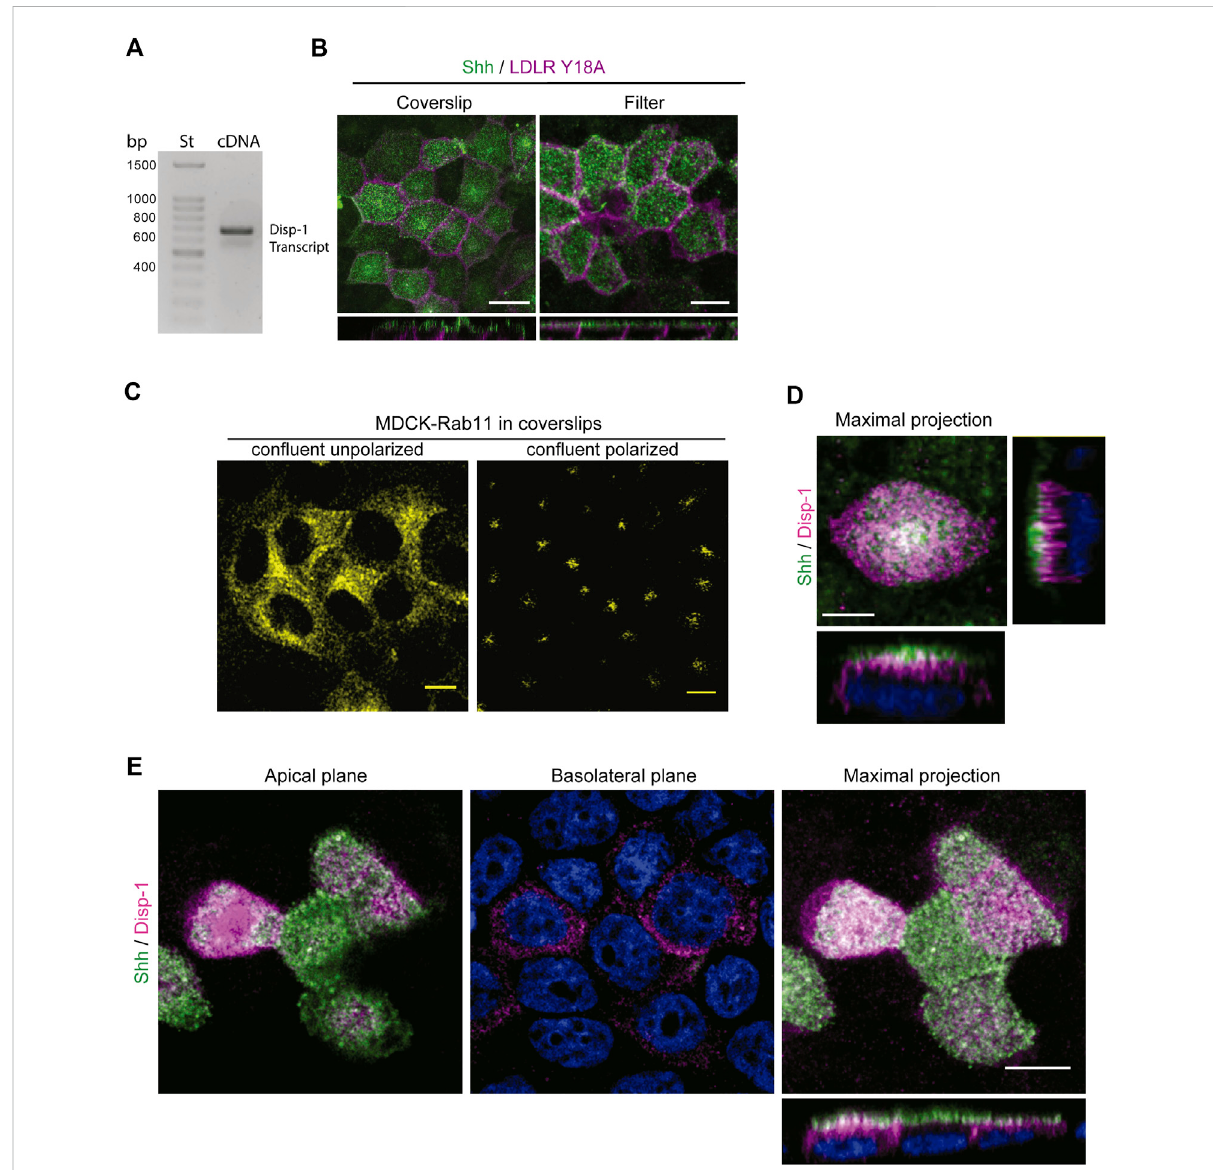
FIGURE 5 Distribution of Disp-1 in polarized MDCK cells. (A) Endogenous Disp-1 expression in MDCK cells. RT-PCR shows the expected band of 562 bp accordingtoprimers(seeMaterialsandMethods). (B) MDCKcellsgrowninglasscoverslipsorTranswell fi ltersfor3 – 4daysafterreachingcon fl uence were microinjected with expression plasmids for Shh and LDLR-GFP-Y18A, incubated for 4 h at 37 ° C and processed to detect each expressed protein. Indirect immuno fl uorescence of Shh (green) and direct imaging of LDLR-GFP-Y18A (magenta) in permeabilized cells show a similar apical and basolateral distribution, respectively, in glass coverslips and fi lters, validating the polarity conditions. (C) Rab11-ARE distribution in non- polarized and polarized MDCK cells. MDCK cells stably transfected with Rab11-CFP cDNA were grown on glass coverslips until con fl uence (left) or 3 – 4 days after con fl uence (right), then fi xed, and imaged by confocal microscopy. The characteristic disperse perinuclear distribution is shown in non-polarized cells, whereas the punctate-like subapical localization is observed after 3 – 4 days of con fl uence in coverslips. (D) Distribution of Shh relative to Disp-1 expressed by plasmid microinjection. Polarized MDCK cells in glass coverslips were microinjected to coexpress Shh and Disp-1, fi xed and immuno-stained by the apical side with anti-Shh (green) antibody, and then permeabilized and stained for Disp-1 with anti-HA (magenta) antibodies. Disp-1 mainly distributes underneath the apical cell surface stained by non-permeabilized anti-Shh antiody. (E) Polarized MDCK cells grown and treated as in (D) , were fi xed, permeabilized, and stained for total anti-Shh (green) and anti-HA (magenta), showing similar Disp-1 and Shh distribution as in (D) . Scale bar, 10 μ